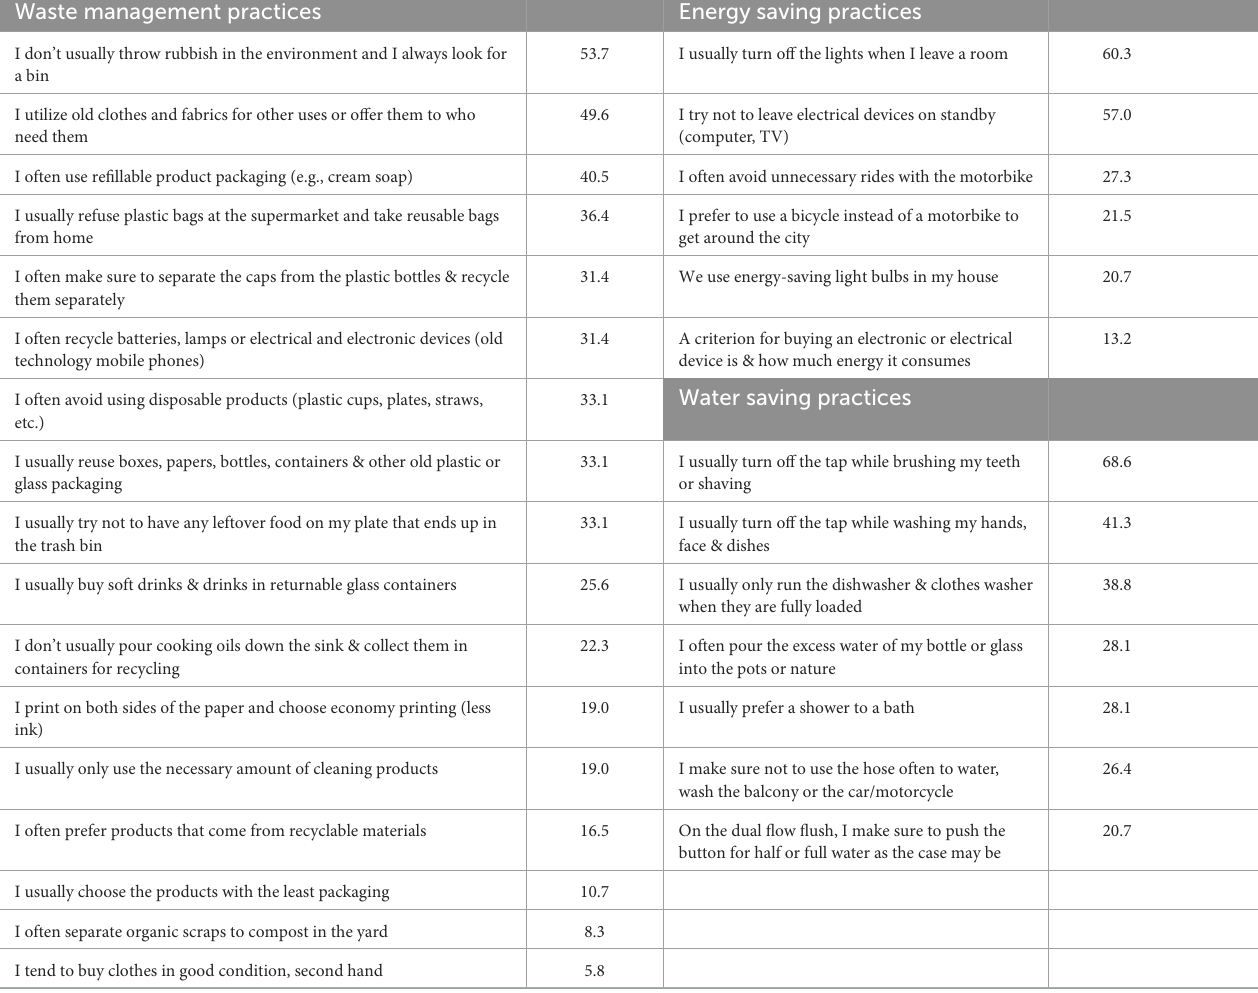
TABLE 3 Students’ behaviors toward waste management, energy, and water saving in percentage ( N =